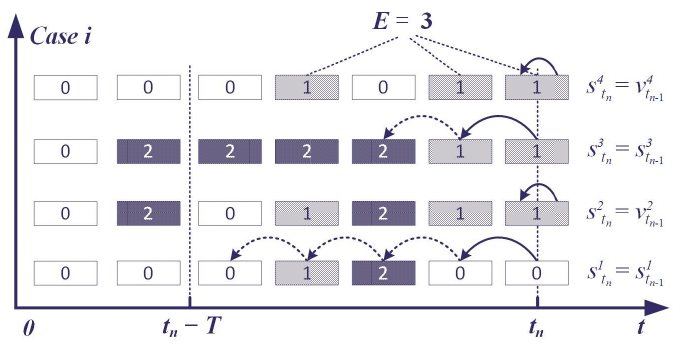
Figure 5. Cases of situation assessment process based on historical status.